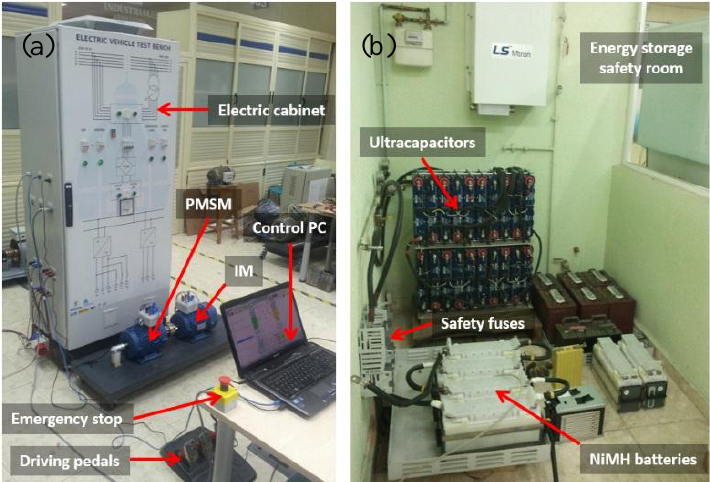
Figure 8. Laboratory test bench: ( a ) Electric cabinet containing three power electronic converters, bench with a PMSM (traction machine) and a IM (emulator machine), and driving pedals; ( b ) safety room for batteries and